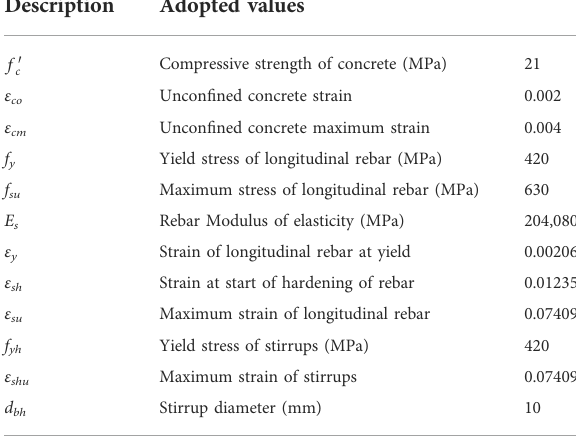
Table 3. The structural costs for beams and columns are